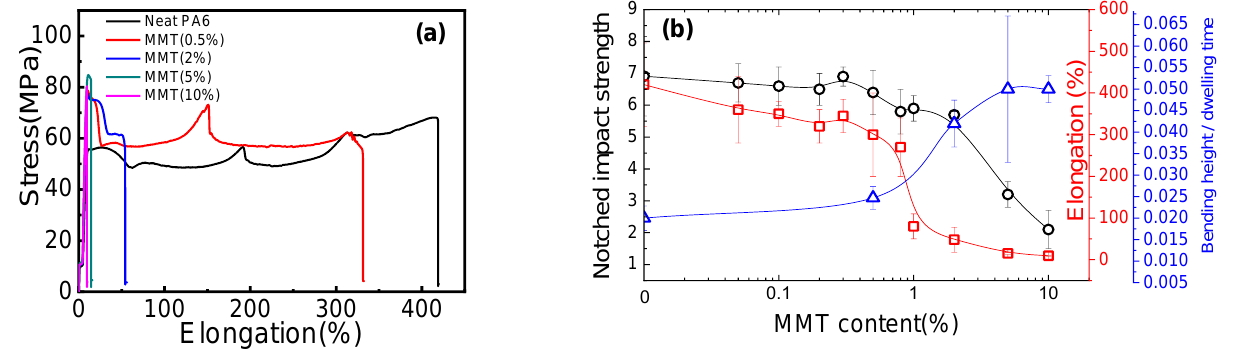
Figure 5. ( a ) Tensile stress strain curves of neat nylon 6 and nylon 6/MMT composites with different MMT composition. ( b ) Notched impact strength, tensile strain at break and bending height/dwelling time of neat nylon 6 and nylon 6/MMT nanocomposites with different MMT